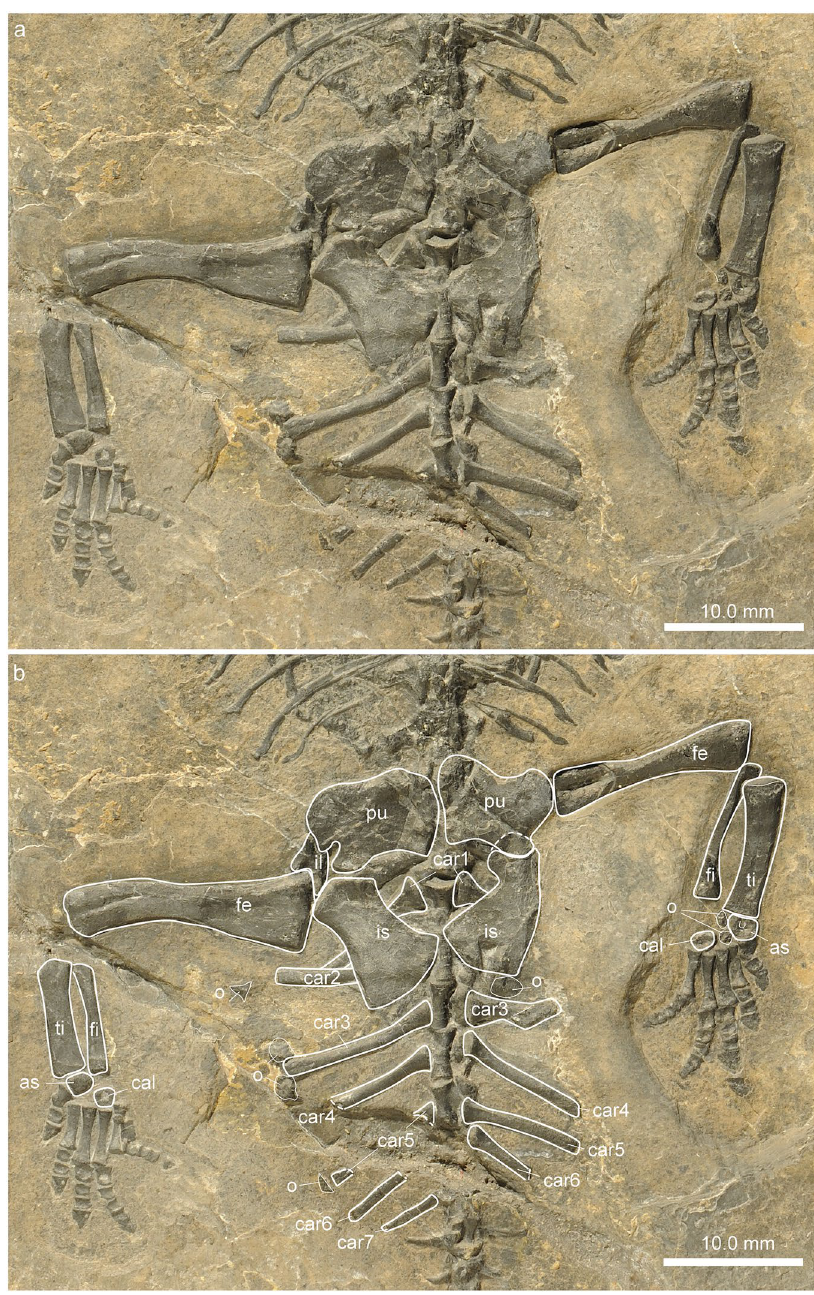
Figure 8. Pelvic and proximal tail region of Eusaurosphargis dalsassoi (PIMUZ A/III 4380). ( a ) Photograph. ( b ) Photograph overlain by interpretative drawing. Abbreviations used in the figure are astragalus (as), calcaneum (cal), caudal rib (car), femur (fe), fibula (fi), ilium (il), ischium (is), osteoderm (o), pubis (pu), and tibia